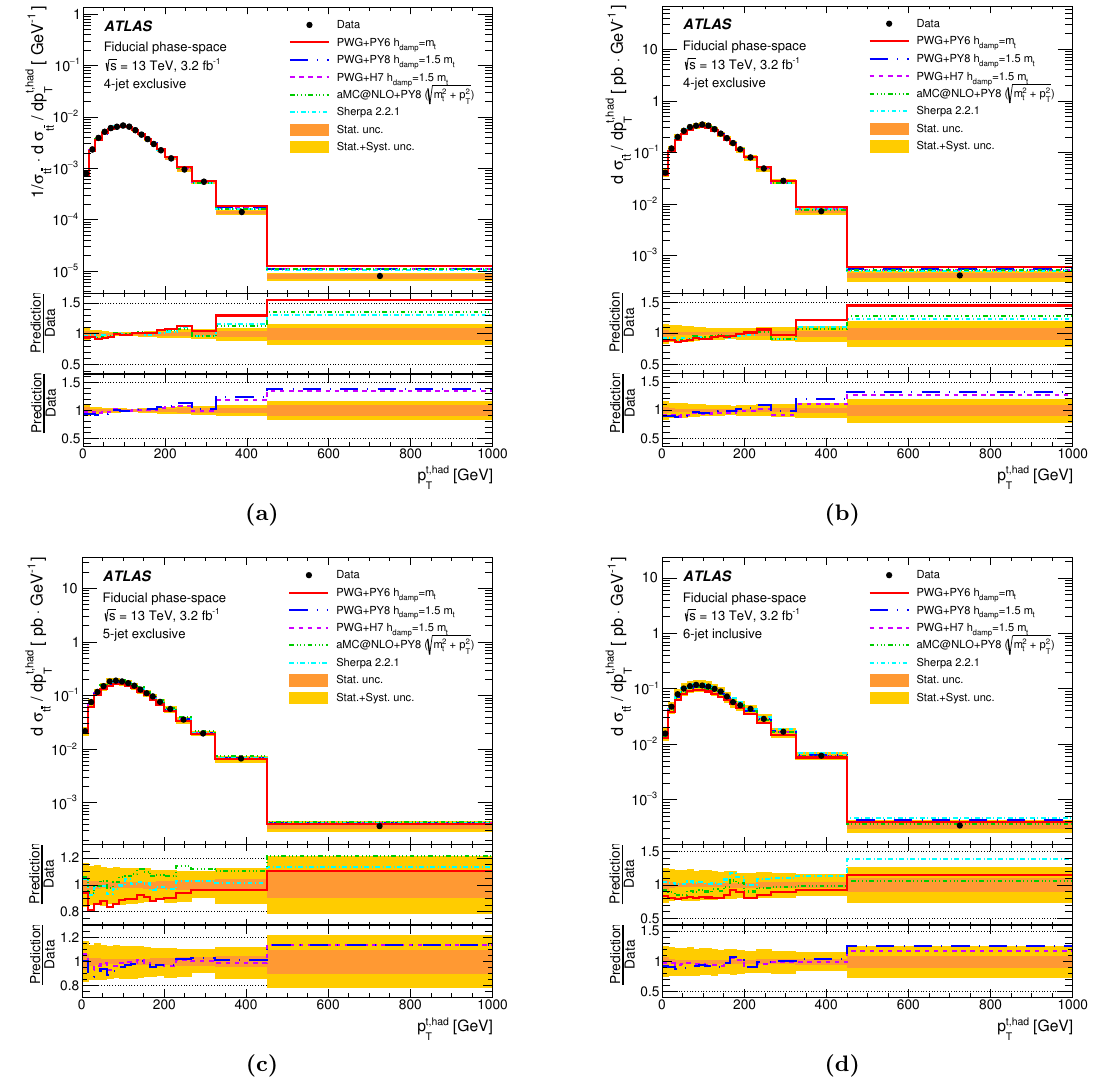
Figure 8 . Di(cid:11)erential cross sections in the (cid:12)ducial phase space as a function of p t; had malised (a) in the 4-jet exclusive con(cid:12)guration, absolute (b) in the 4-jet exclusive, (c) 5-jet ex- clusive and (d) 6-jet inclusive con(cid:12)gurations. The shaded area represents the total statistical and systematic